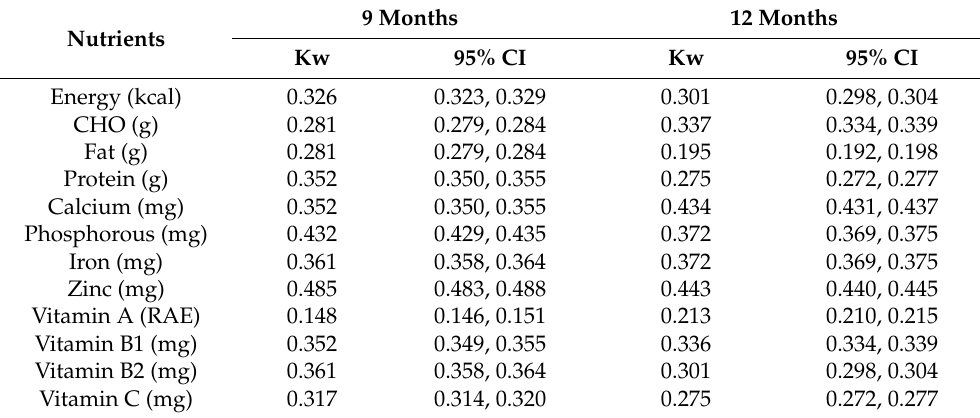
Table 3. Agreements of energy and nutrient intakes between 24-HR and 3-DFR.